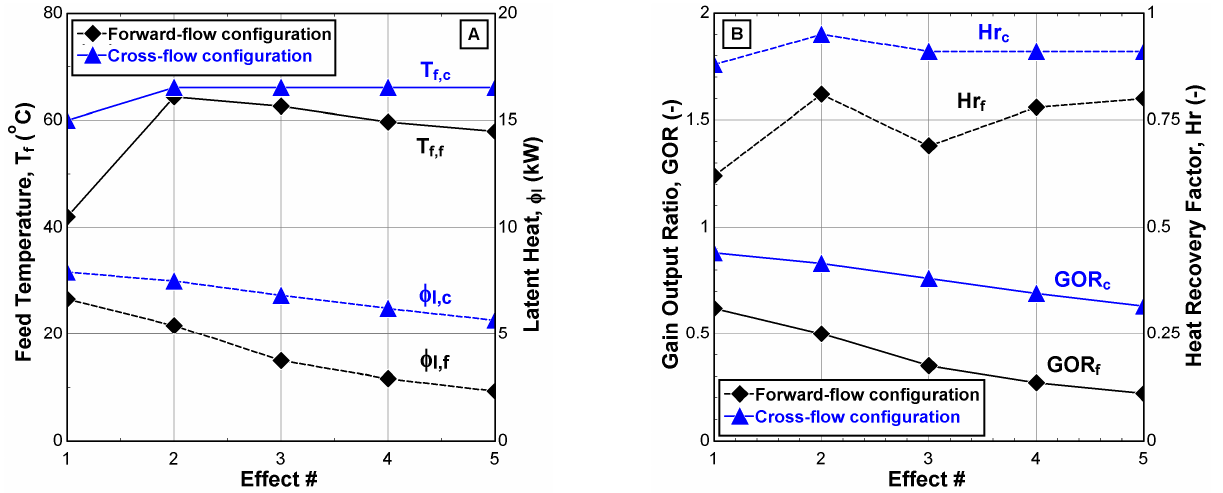
. . v H 1 = 900 L/h, T H 1 = 75 ◦ C, v C 1 = 405 L/h,